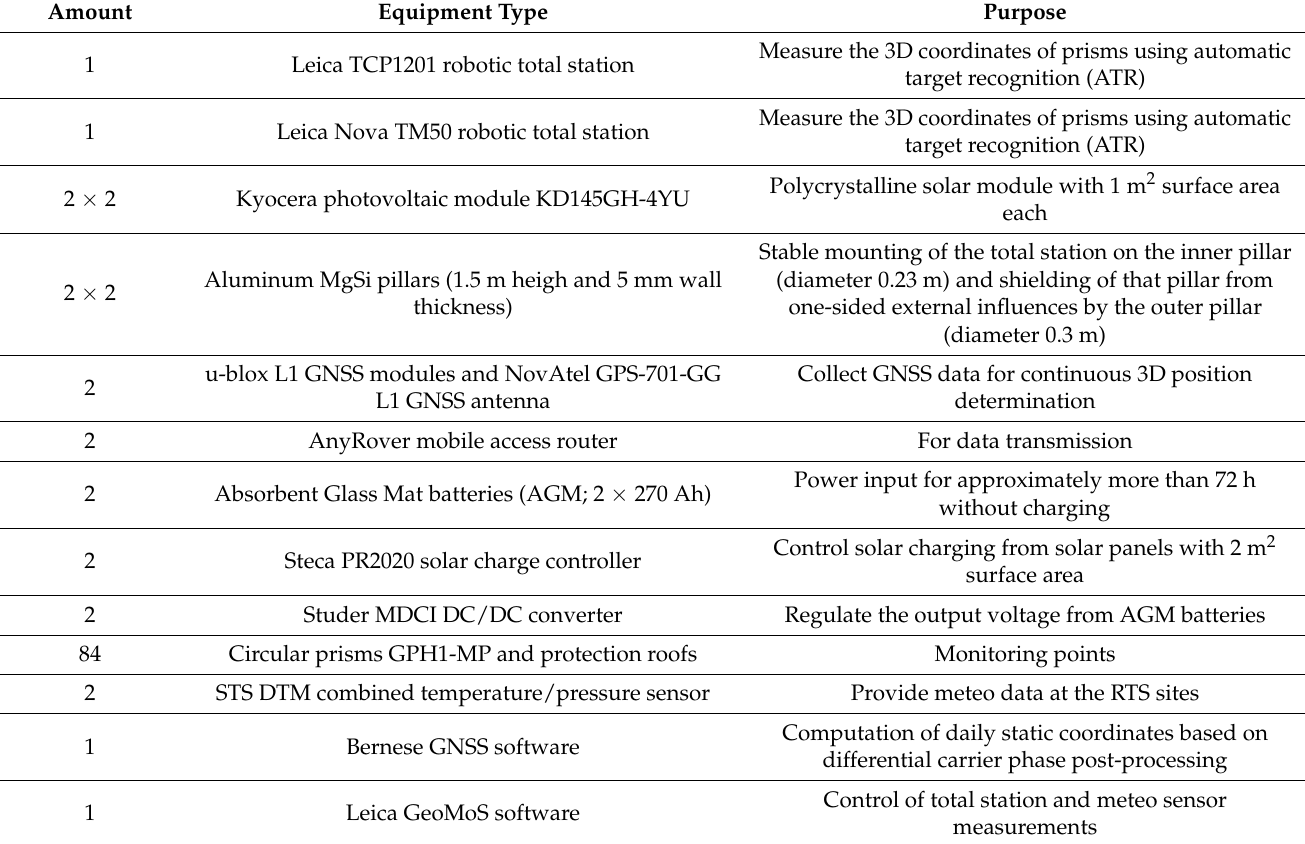
Table 1. Equipment used for the monitoring system at